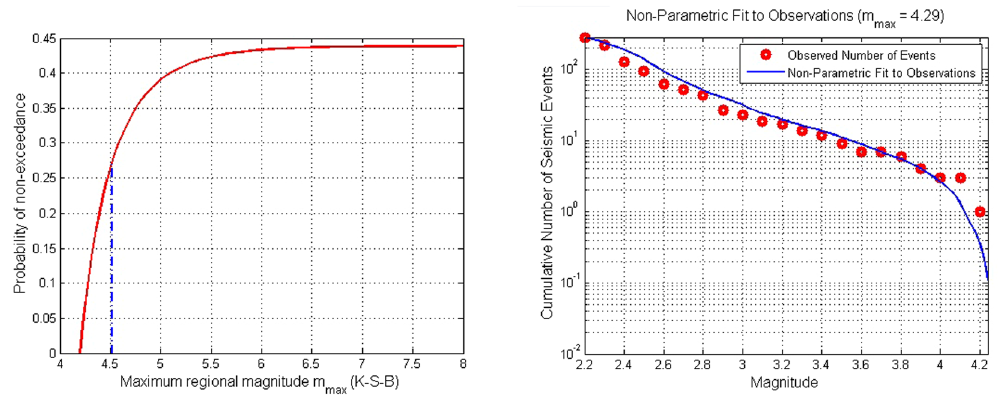
Figure 12. Graphical results of the M max estimation with the K-S-B technique (left panel) and the Non- parametric approach (right panel) taking into account the whole